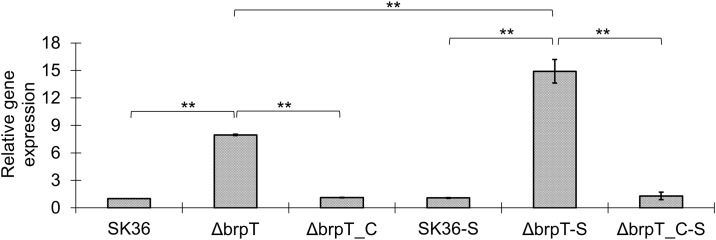
Increased gene expression of gtfP in the brpT mutant.qRT-PCR was used to determine the relative expression of glucosyltransferase, gtfP, in the brpT mutant using gyrA as an internal control. Data shown are mean±SD from three biological replicates. “–S” on the x-axis represents samples cultured in BHI supplemented with 1% sucrose. **, indicates significance with P <0.01.